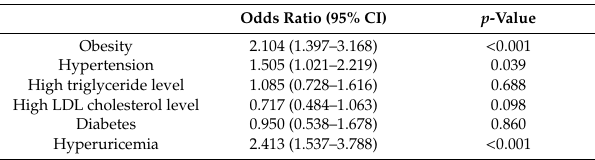
Table 5. Risk factors of chronic kidney disease in NAFLD.